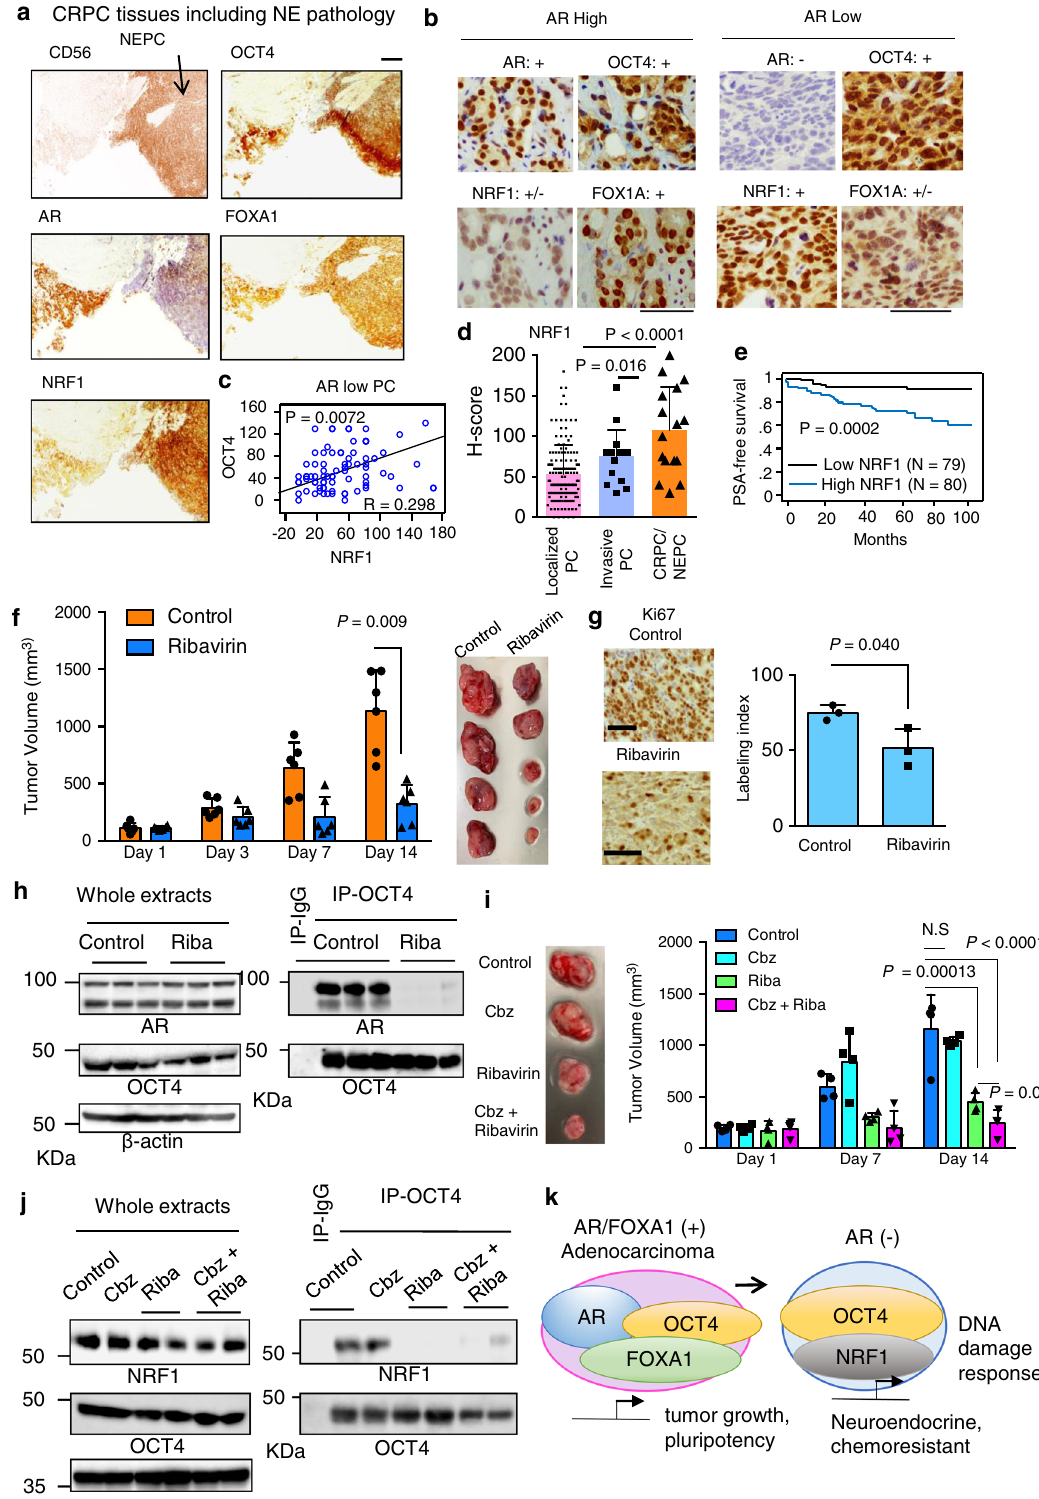
to cancer stem-like cell (CSC) maintenance of lethal PC, we tested the ef fi cacy of ribavirin in patient-derived cell spheroid culture system 55,56 , which forms a sphere from clinical samples that has a multidrug resistant phenotype. Spheroid formation was inhibited